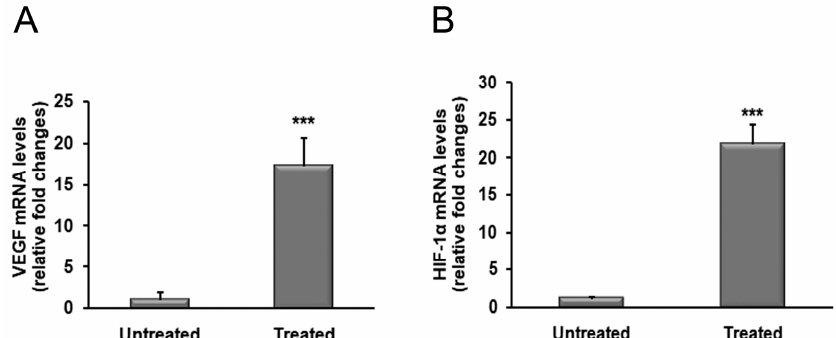
Figure 4. Changes in mRNA levels of VEGF and HIF-1 α in foreskin tissues from patients with BXO untreated or treated with OZOILE ® . The results are the means of data obtained from 15 untreated patients and 15 treated patients. Error bars represent standard error of the mean (SEM). *** p < 0.001 significant differences in comparison with untreated patients.